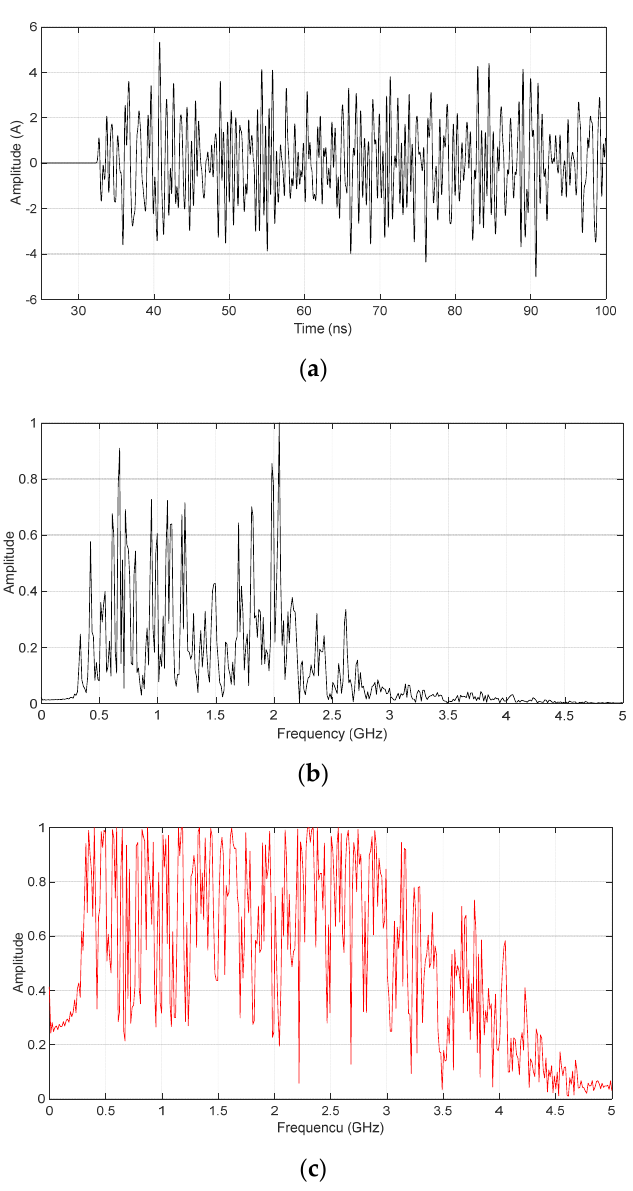
Figure 11. The signal received by the sensor installed in the 3D transformer tank modeled in the CST-MWS software: ( a ) time-domain waveform; ( b ) normalized magnitude spectrum of the time-domain waveform; ( c ) normalized magnitude spectrum of the inverted signal.